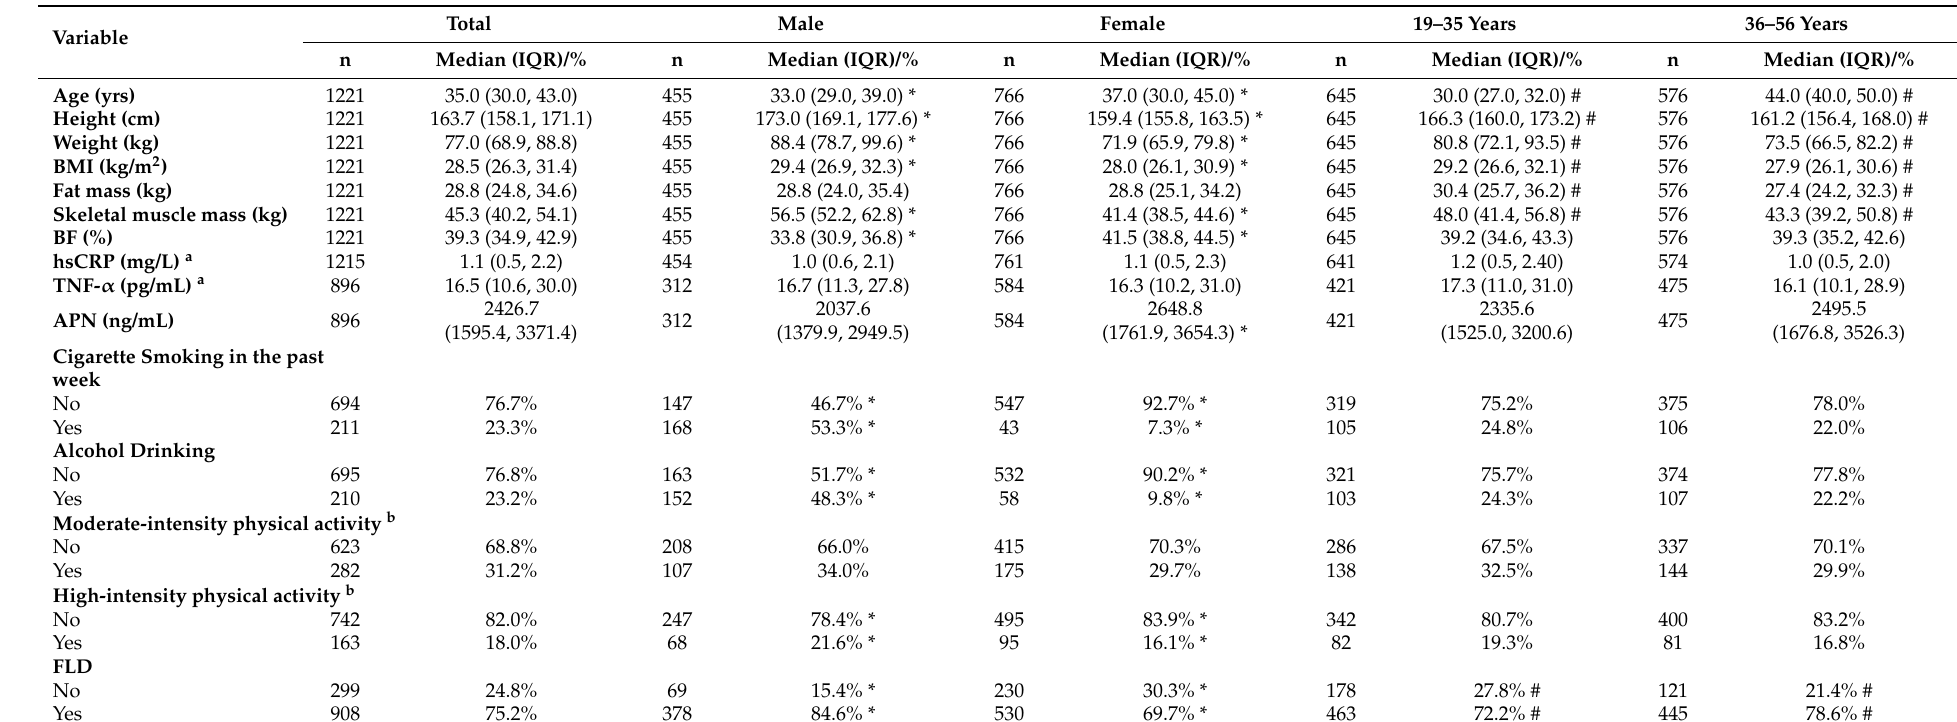
Table 1. Basic Characteristics of